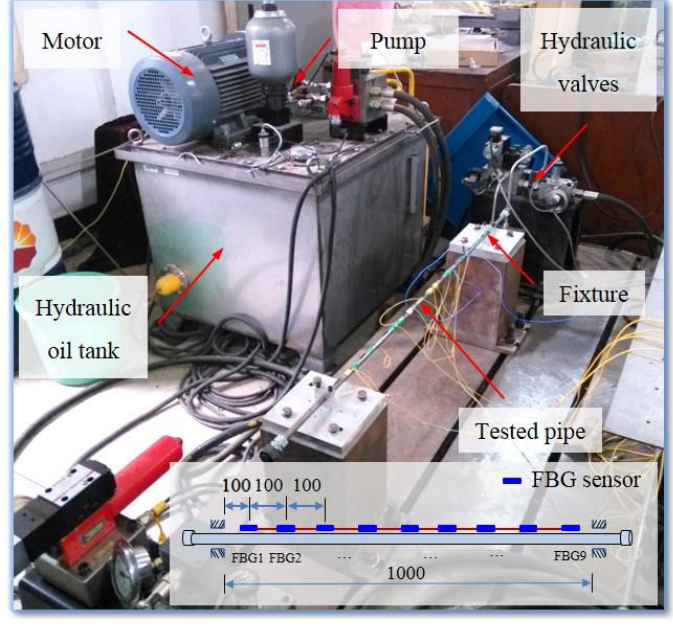
Figure 9. Hydraulic platform and tested pipe with FBG sensors.